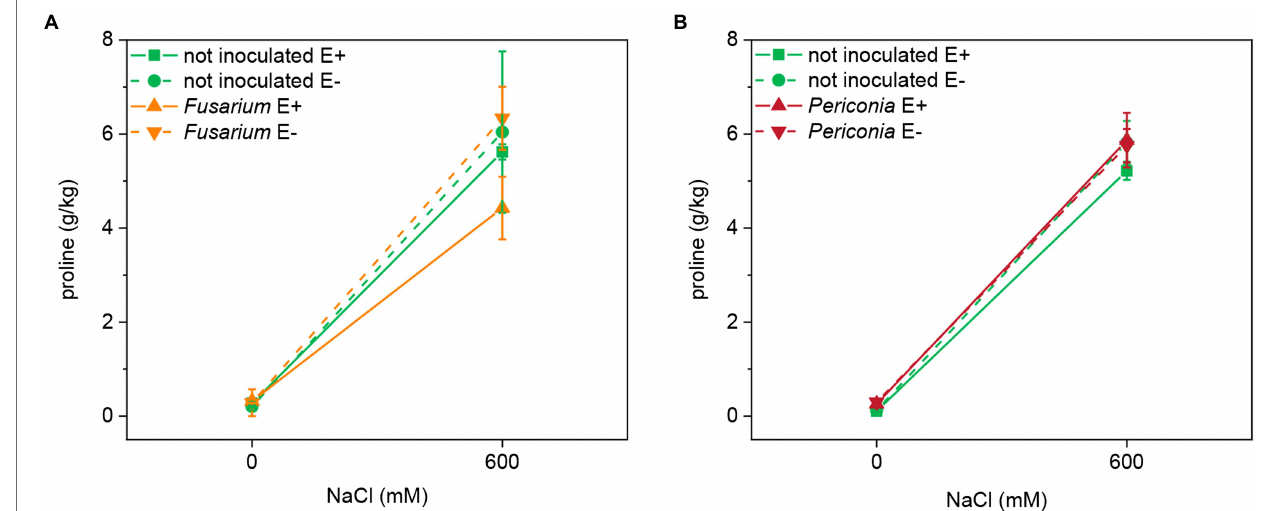
FIGURE 4 | Leaf proline content at two different salinity treatments (0 and 600 mM NaCl) in two FRP lines, EB15 (A) and TH12 (B) , each one composed by clones symbiotic with E. festucae (E + ) or Epichloë free (E – ), and inoculated with F. oxysporum T48 (orange) or P. macrospinosa T131 (dark red), or uninoculated